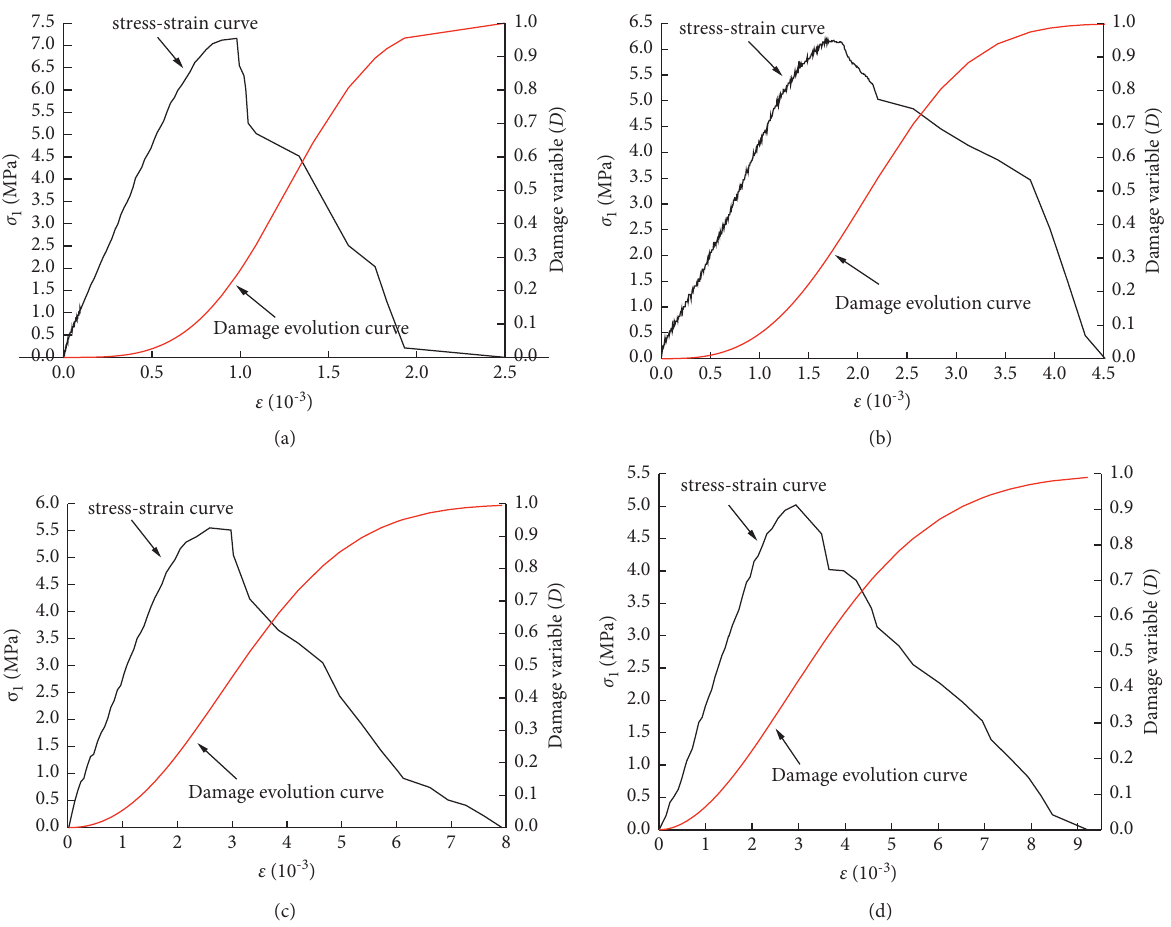
Figure 9: Damage evolution curves of uniaxial compression with different water contents: (a) 0% water content; (b) 1.5% water content; (c) 2.7% water content; (d) 3.09% water